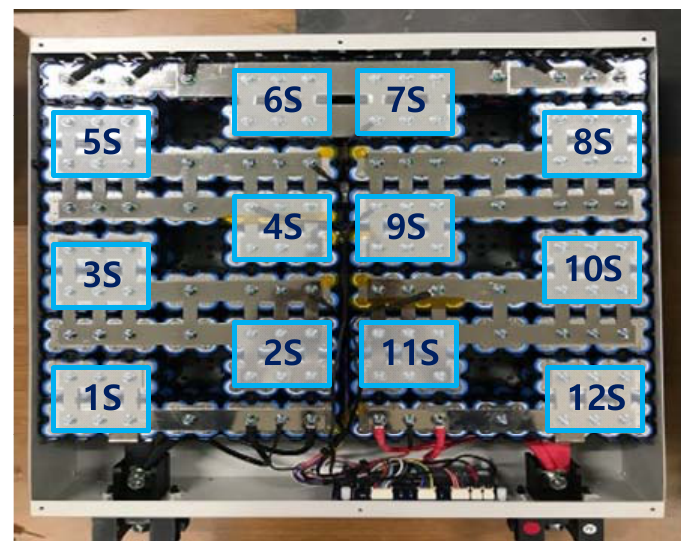
Figure 1. A 12S28P LiNiCoAlO 2 (NCA) series / parallel battery pack for frequency regulation energy storage system (FRESS).